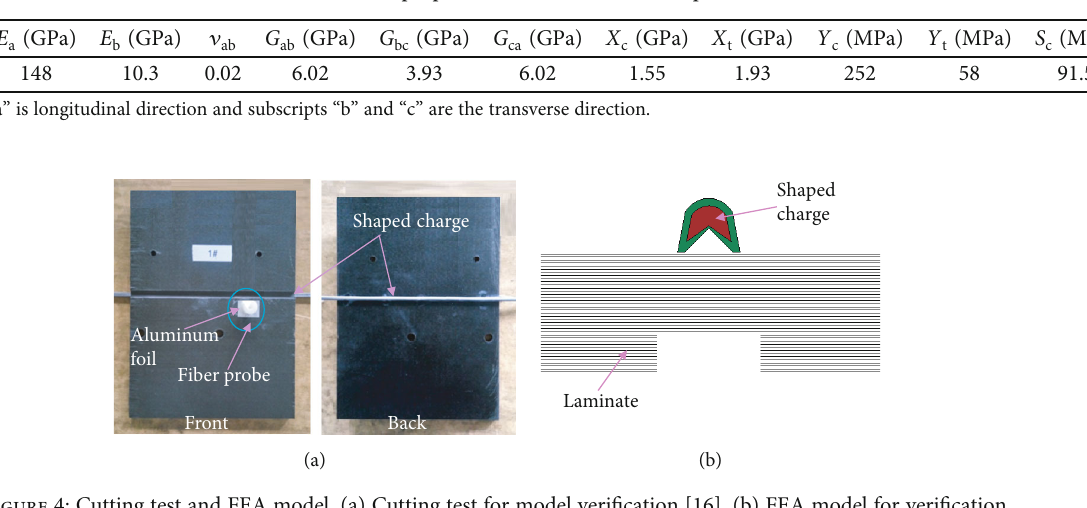
Table 2: Material properties of unidirectional composites.